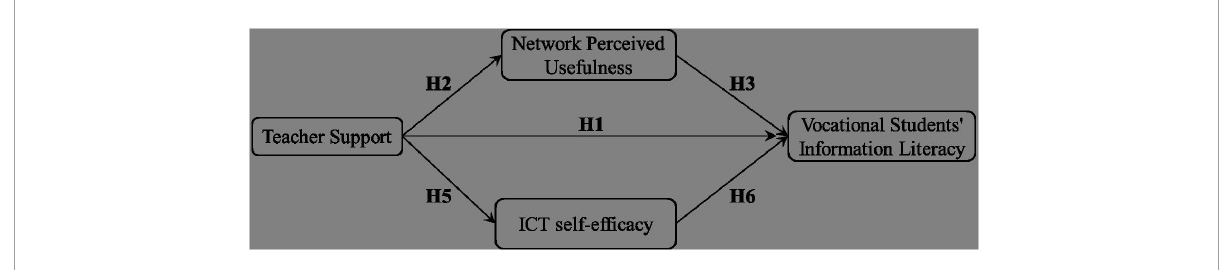
FIGURE1 Theoretical model of the relationship between teacher support and information literacy of higher vocational